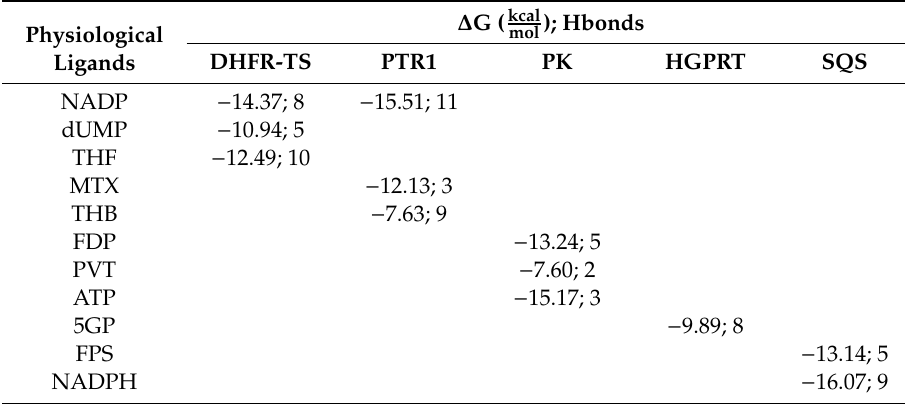
Table 3. Predicted binding free energy and hydrogen bonds. The physiological ligands were docked in five Leishmania targets according to the reaction catalyzed.